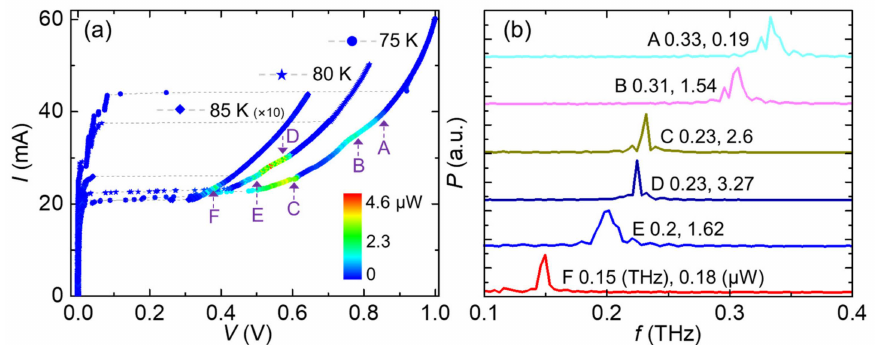
Figure 3. ( a ) Transport and terahertz emission characteristics of the BSCCO stack at T b = 75 K, 80 K and 85 K. Colors indicate the emission power (multiplied by a factor of 10 for the T b = 85 K data) detected by the Golay cell. ( b ) Fourier spectra of the emission for the bias points A – F indicated in ( a ); the numbers next to the labels are the values of emission peak frequencies and emission power. The data in ( b ) are rescaled to yield similar heights of the emission